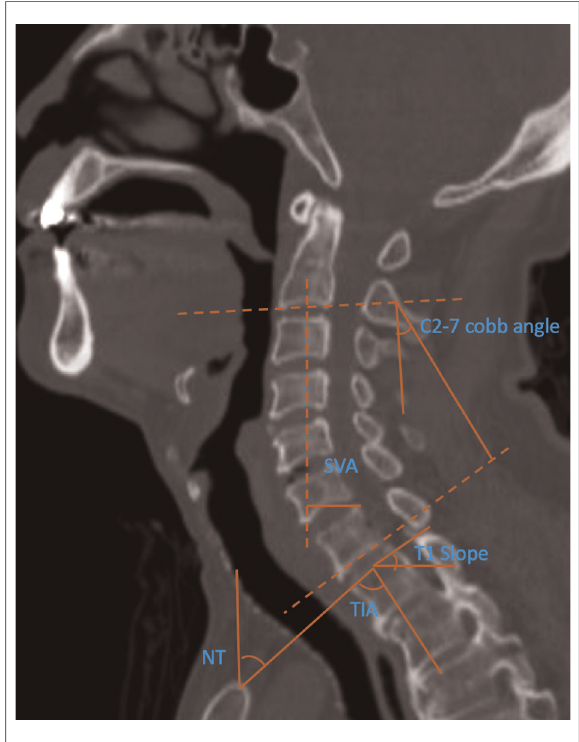
FIGURE 2 Radiographic evaluation of T1 slope, NT (neck tilt), and TIA (thoracic inlet angle), C2 – 7 Cobb angle, and C2 – 7 SVA (sagittal vertical